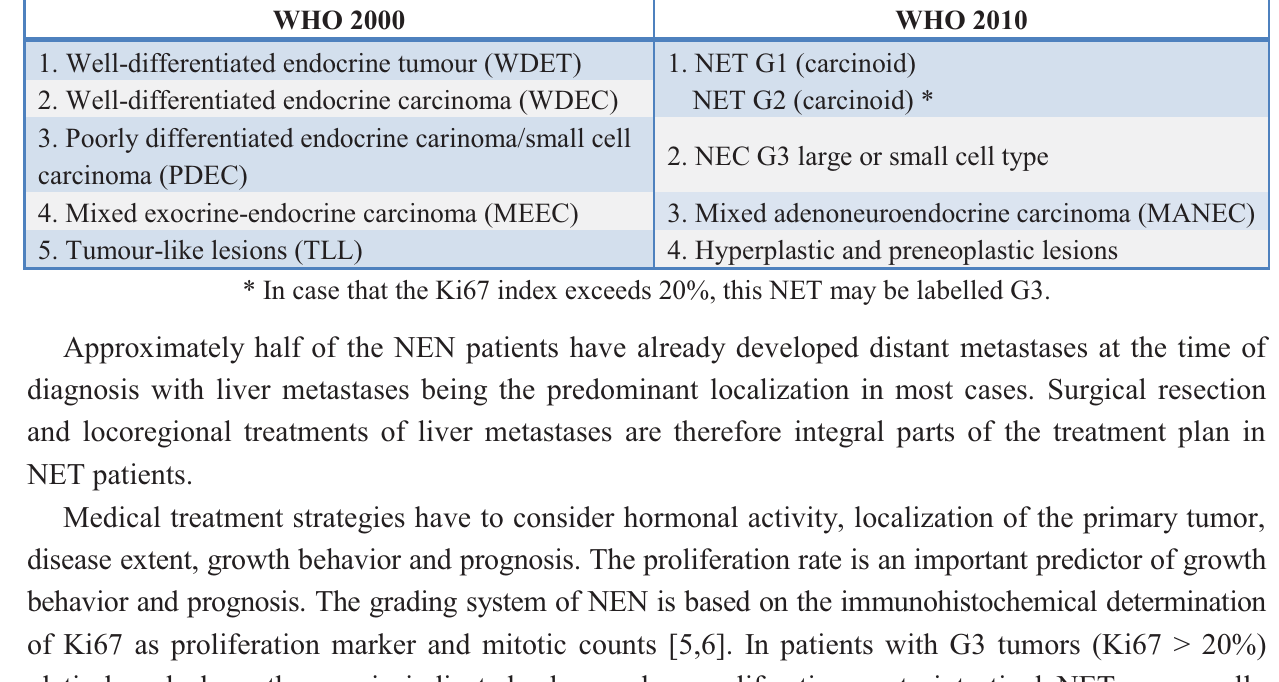
Table 1. WHO classification of neuroendocrine neoplasms of the gastroenteropancreatic system [4]. WHO